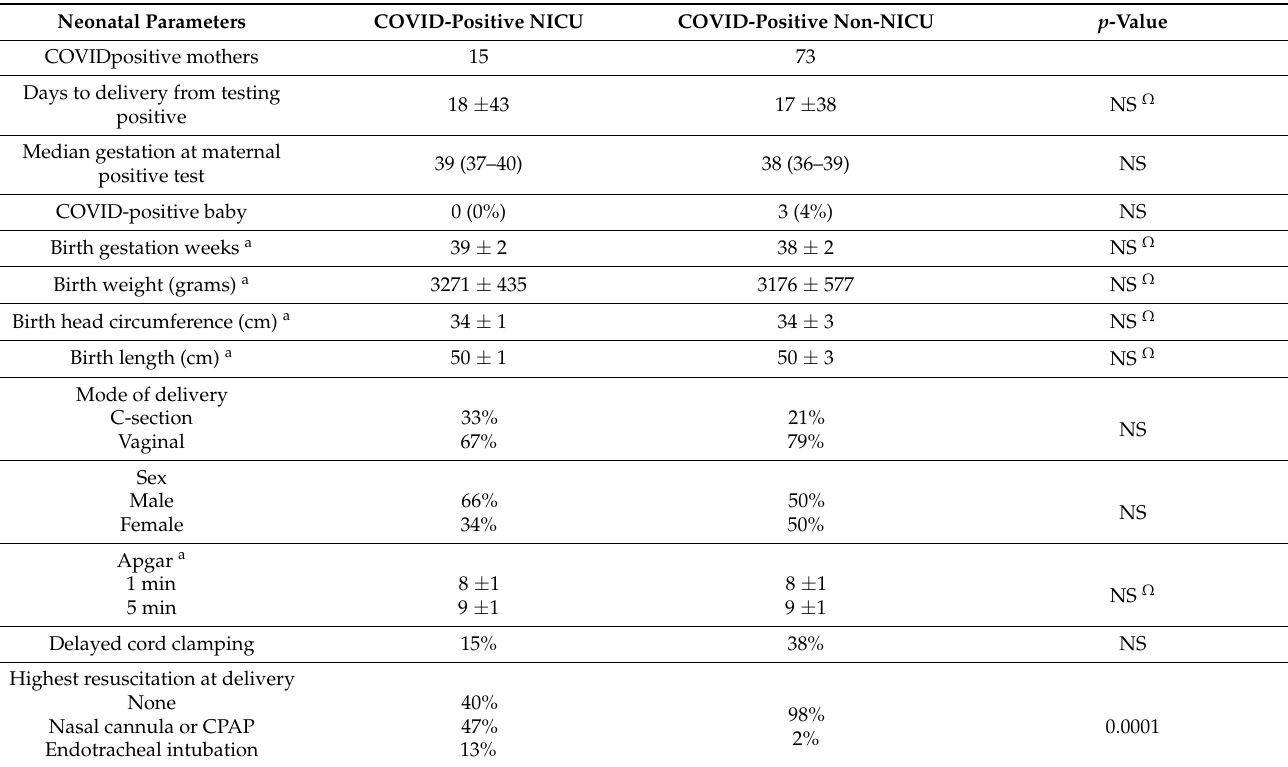
Table 2. Characteristics of neonates of SARS-CoV-2-positive mothers admitted to the NICU vs. those who were